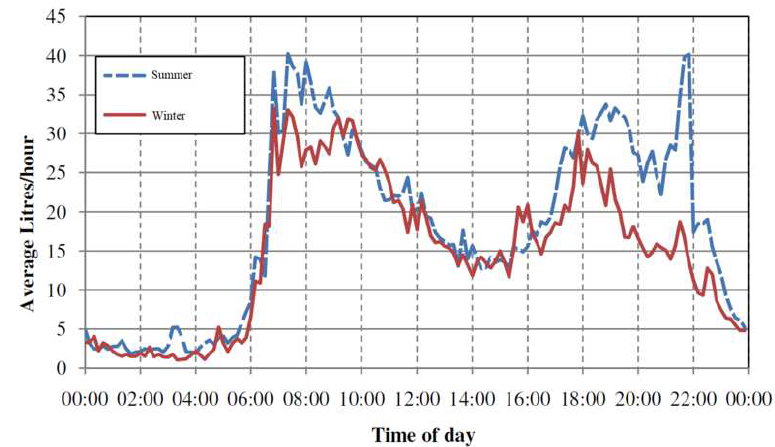
Figure 7. Average daily household water usage profile [27] (Copyright 2010,